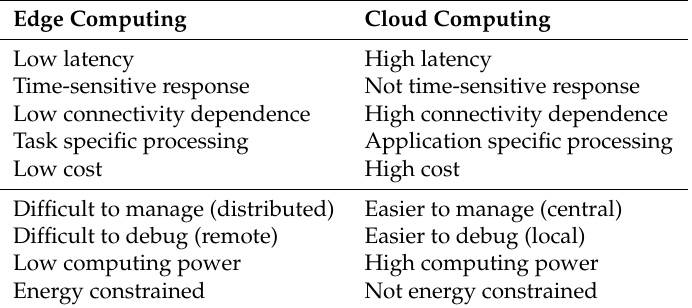
Table 1. Edge computing versus cloud